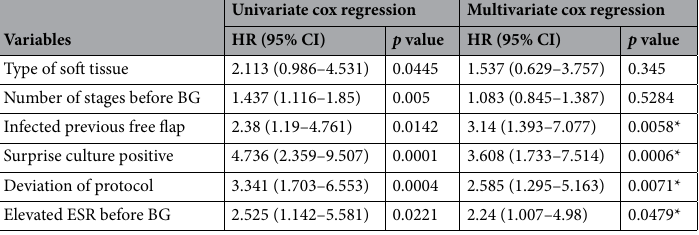
Table 3. Risk factor analysis of Recurrence of Infection. *Significant at p value < 0.05. BG: bone